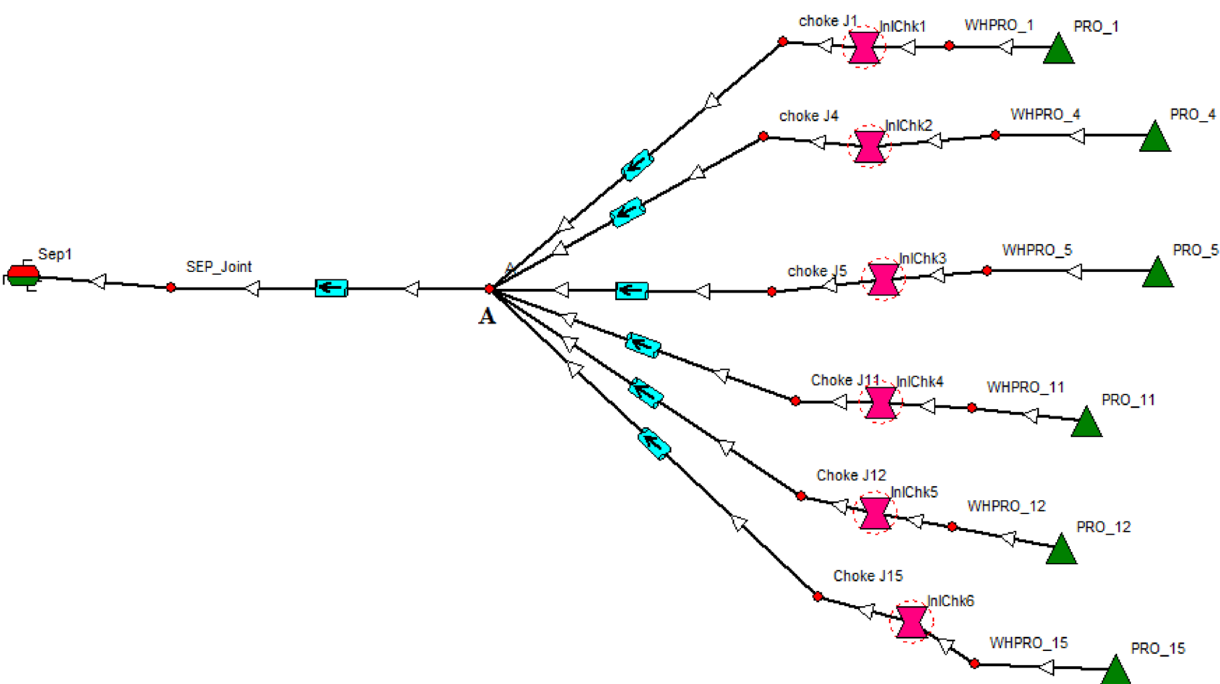
Fig. 1 Schematic diagram of connection of six wells to the manifold and separator